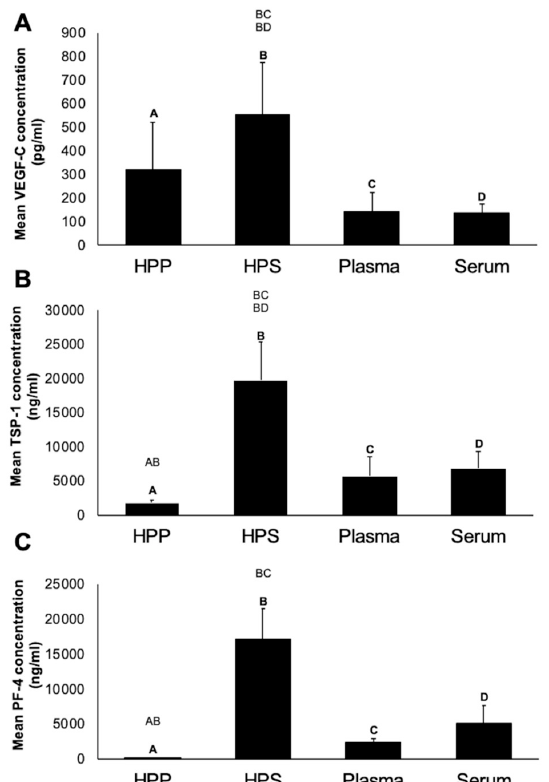
Figure 2. Quantitative analysis of pro- (VEGF-C) and anti- (TSP-1, PF-4) angiogenic / lymphangiogenic growth factor concentration in blood-derived secretomes. Plots showing the concentration of ( A ) VEGF-C (pg / mL), ( B ) TSP-1 (ng / mL), ( C ) PF-4 (ng / mL) in hypoxia preconditioned plasma (HPP) and serum (HPS), as well as fresh plasma and serum obtained from 5 young, healthy subjects as analysed by ELISA. Capital letter pairs over plots indicate statistical comparison of corresponding data points. For all pair comparisons, p < 0.05, unless otherwise indicated. Error bars represent s.d. ( n = 5).